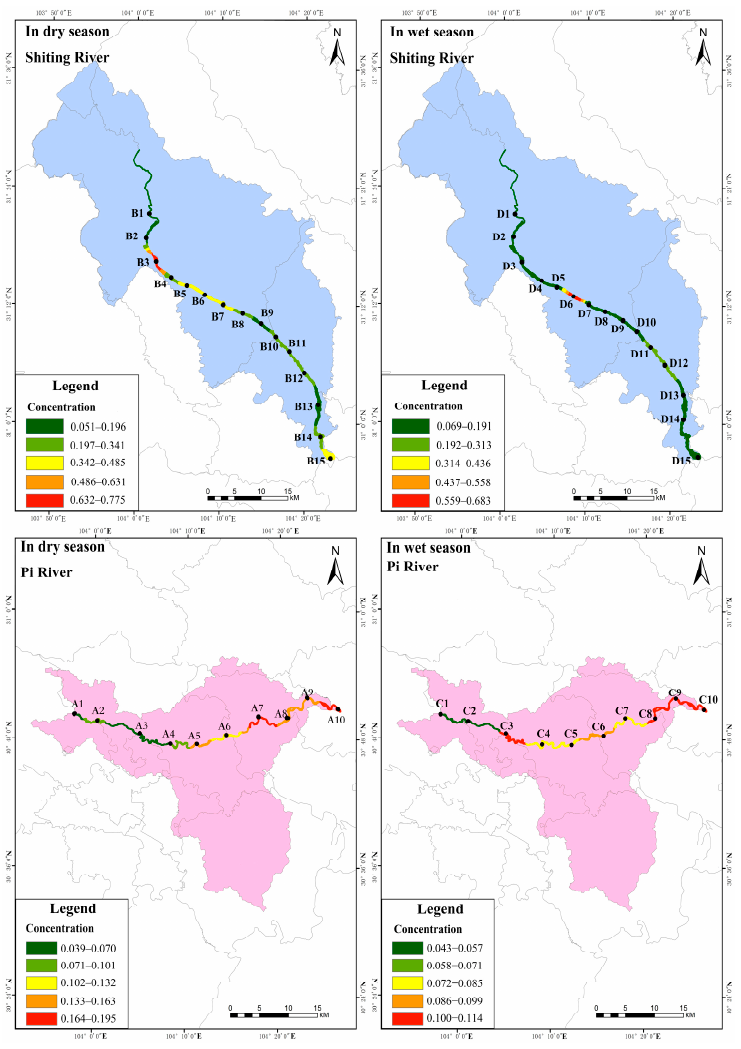
Figure 3. Spatial distribution of TP in water of the study area.